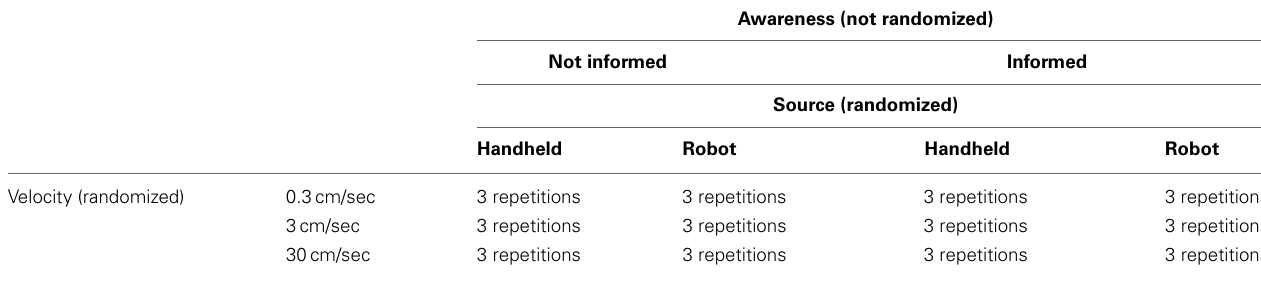
Table 1 | Experimental design and